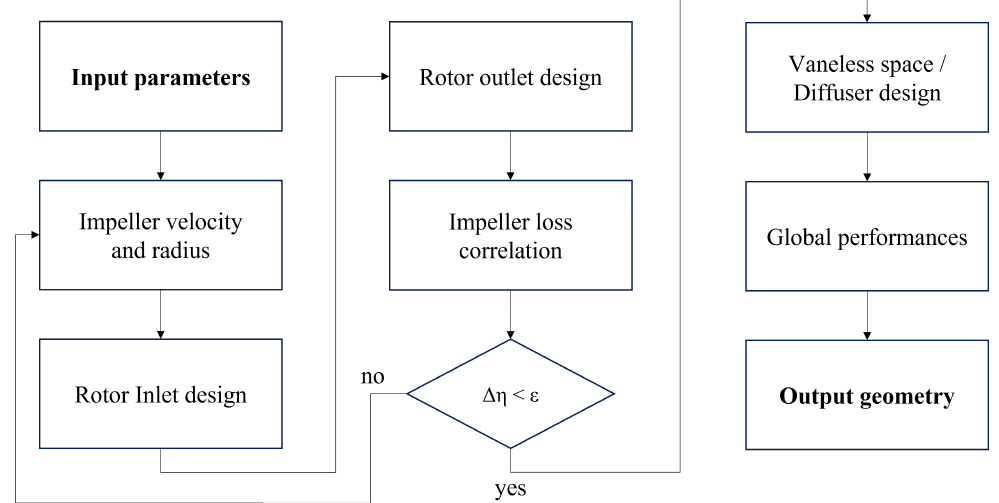
Figure 1. Centrifugal compressor 1D design